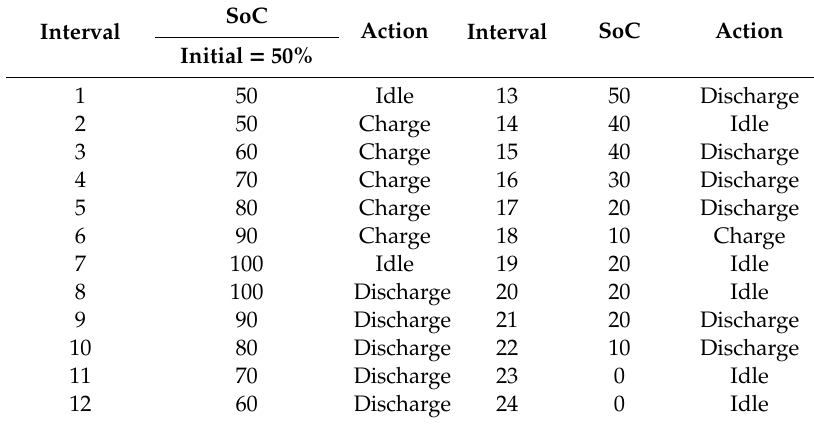
Figure 8. The operation of CBESS based on the Q-table with a different number of episodes. Table 2. CBESS actions with 50,000 episodes.